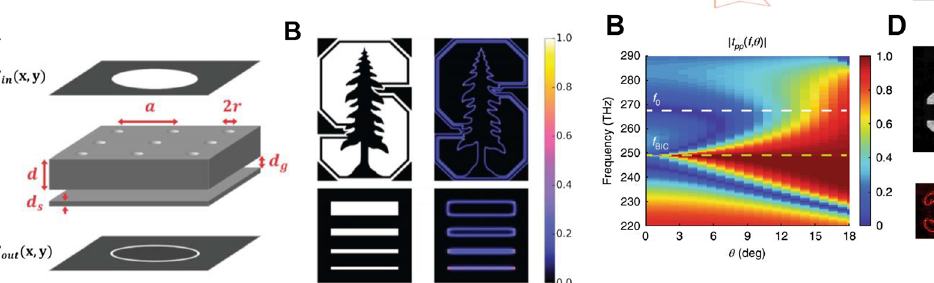
Figure 13: Two-dimensional (2D) image differentiation using nanophotonic materials